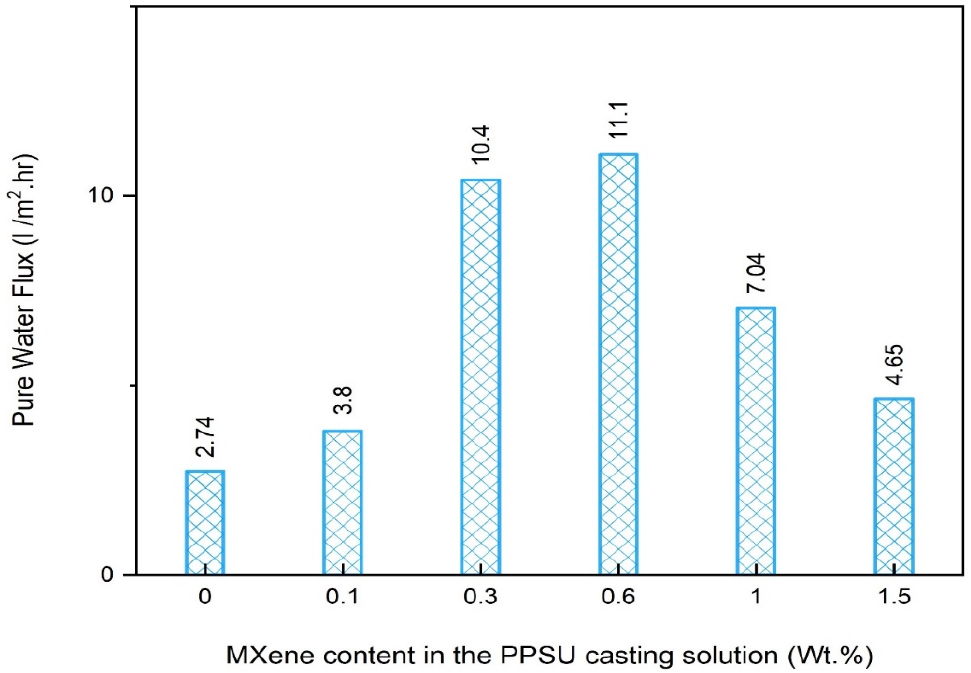
Figure 10. Pure water fl ux of membranes at various loading weights of MXene and 3-bar operating